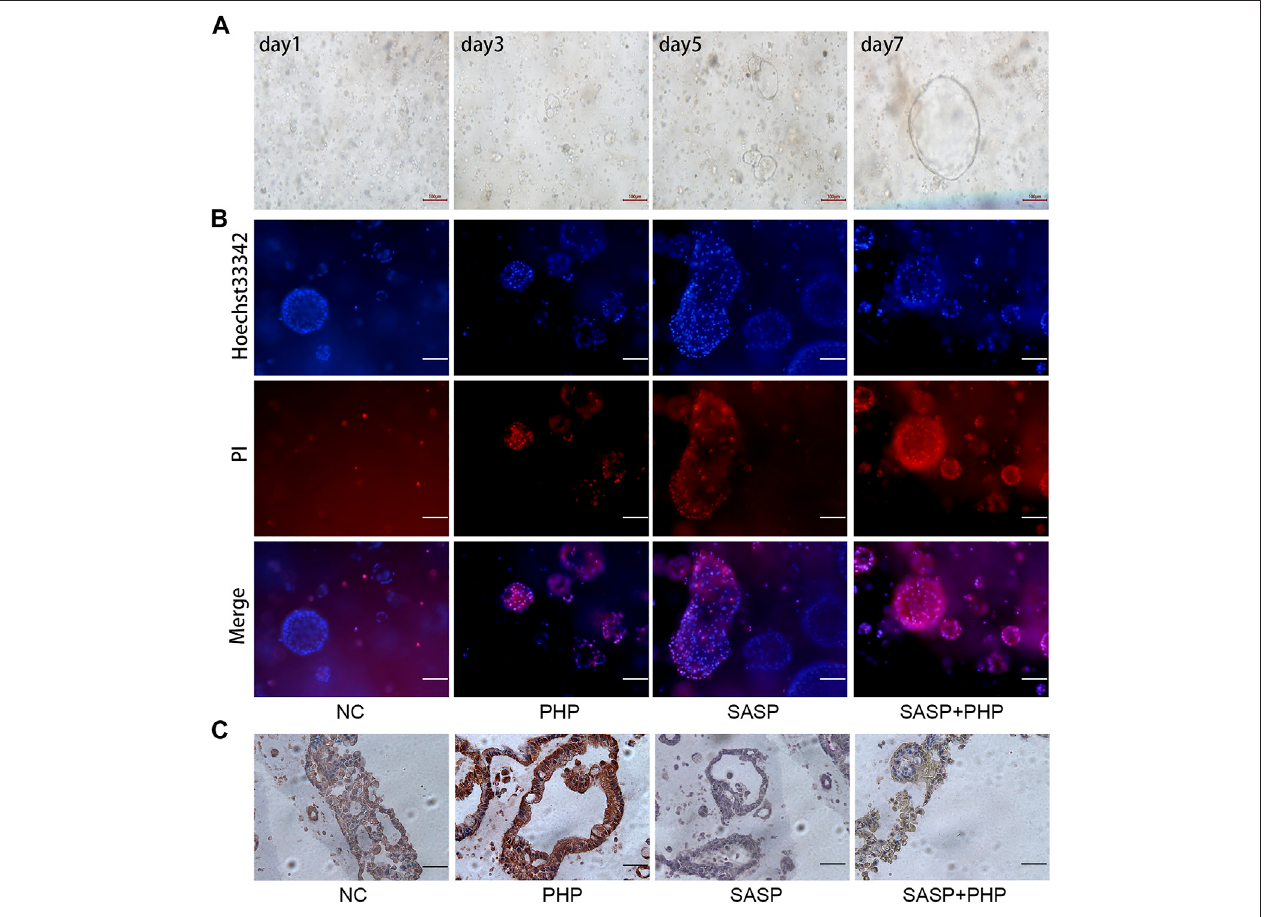
FIGURE6| SASPsensitizes the anti-tumour effect ofPHP-PDTincholangiocarcinomaorganoids. (A) The growth oforganoids ondays 1, 3, 5and 7. (B) Hoechst 33,342 and PI were used to label the live and dead cells, respectively, of NC, PHP-PDT, SASP and the combination group. (C) The changes in xCT expression in cholangiocarcinoma organoids after SASP and PHP-PDT treatment alone or in combination.